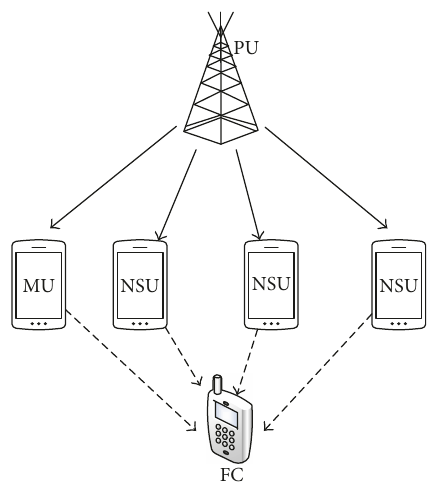
Figure 1: The conventional CSS